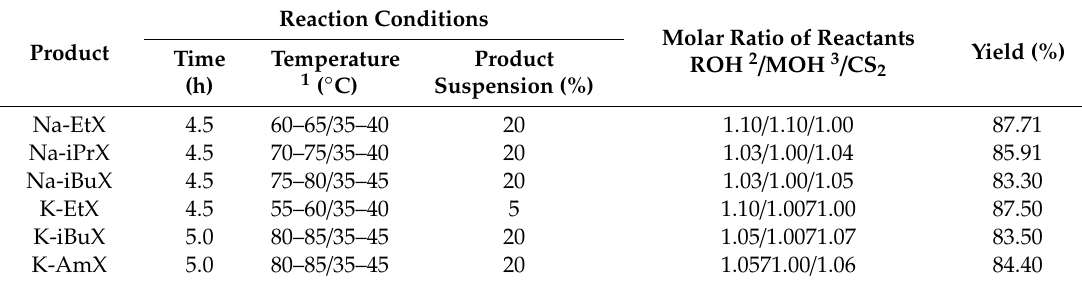
Table 5. Results of the optimization of sodium / potassium alkyl xanthates